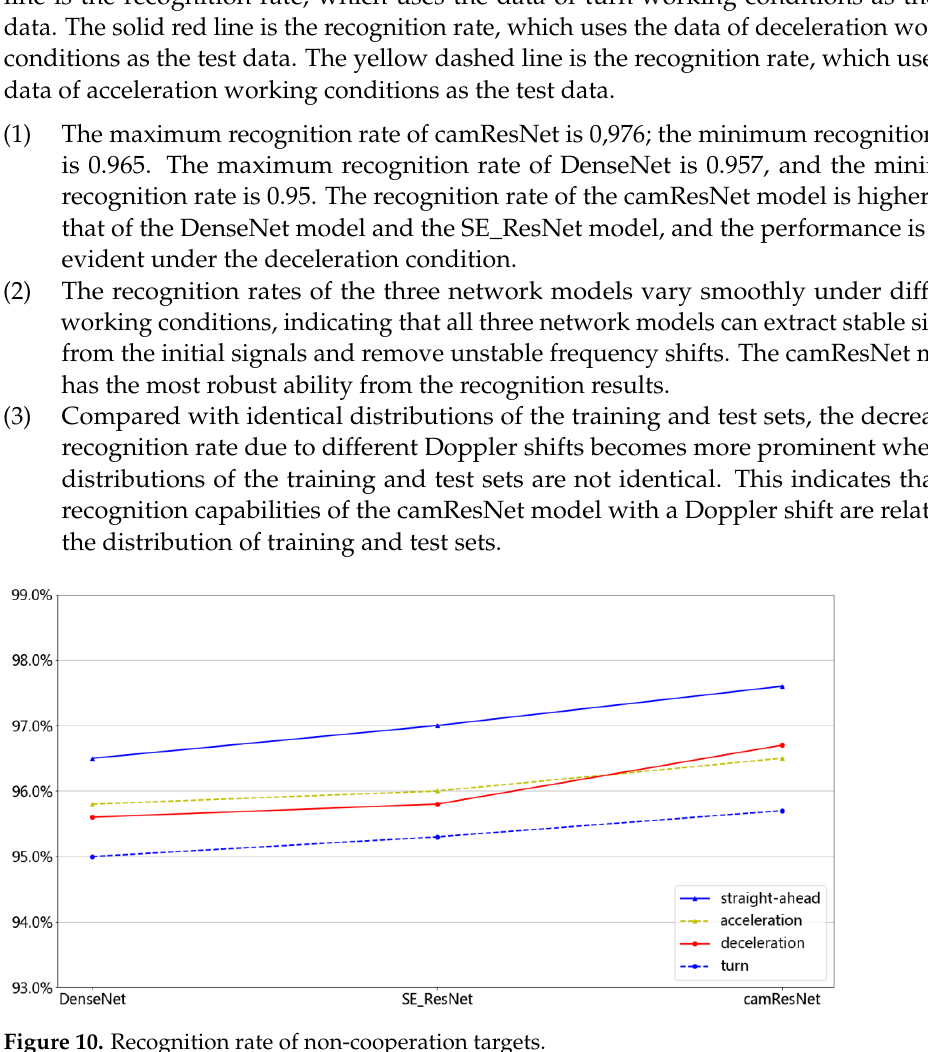
Figure 10. Recognition rate of non-cooperation targets.